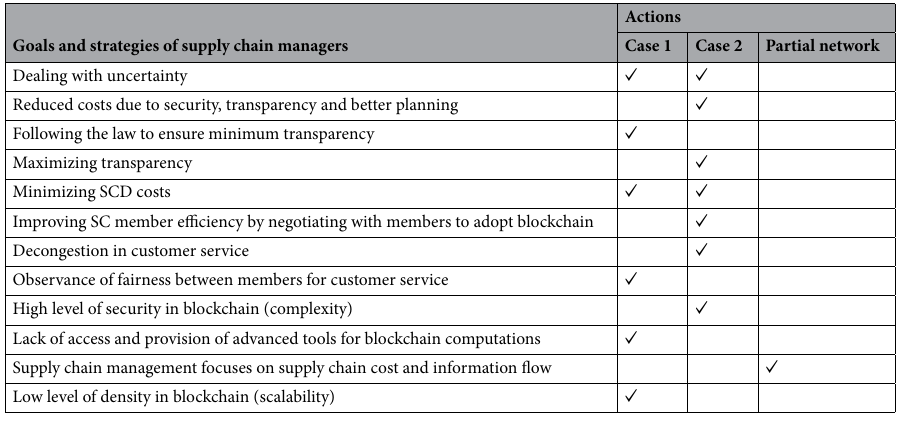
Table 5. Goals of supply chain managers and recommended